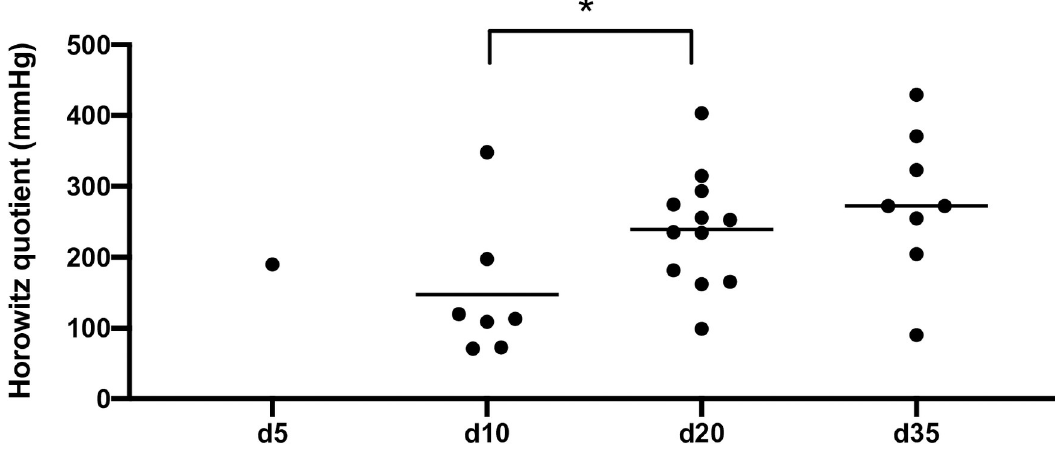
Fig 3. Horowitz quotient calculated at day 5, 10, 20 and 35 after symptom onset with a significant lower Horowitz quotient at day 10 in comparison to day 20 and 35. ( � p < 0.05).